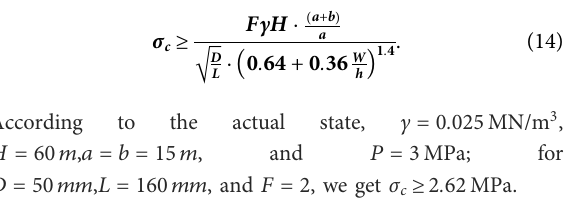
FIGURE 5 Different particle size percentages of gangue: (A) washed gangue; (B) crushed gangue.